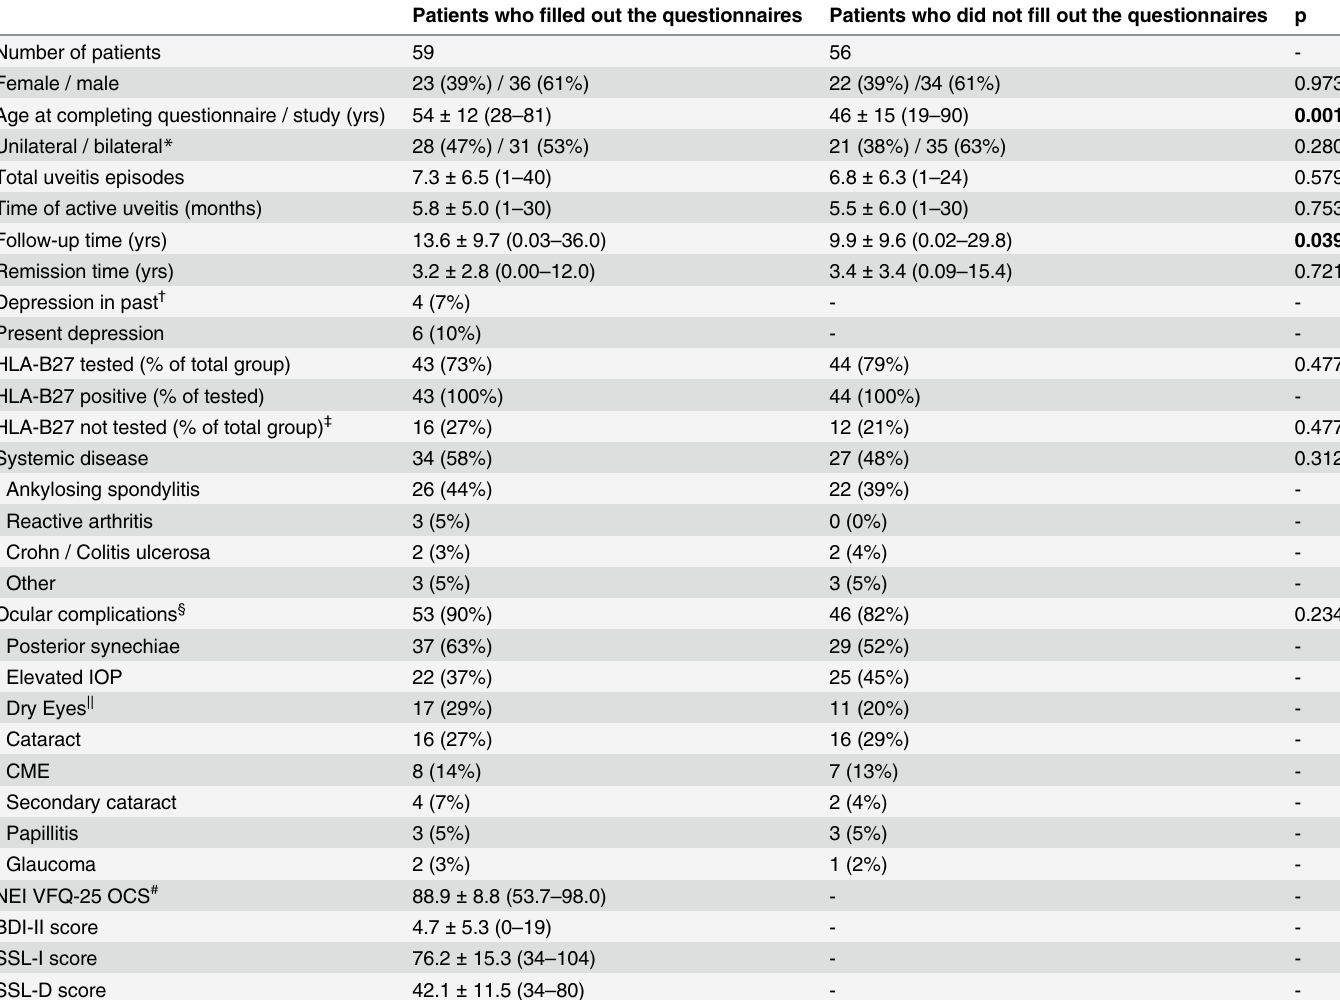
Table 1. clinical characteristics of HLA-B27 associated AU patients and overall scores on questionnaires (N and (%) or Mean ± SD (range)). Patients who fi lled out the